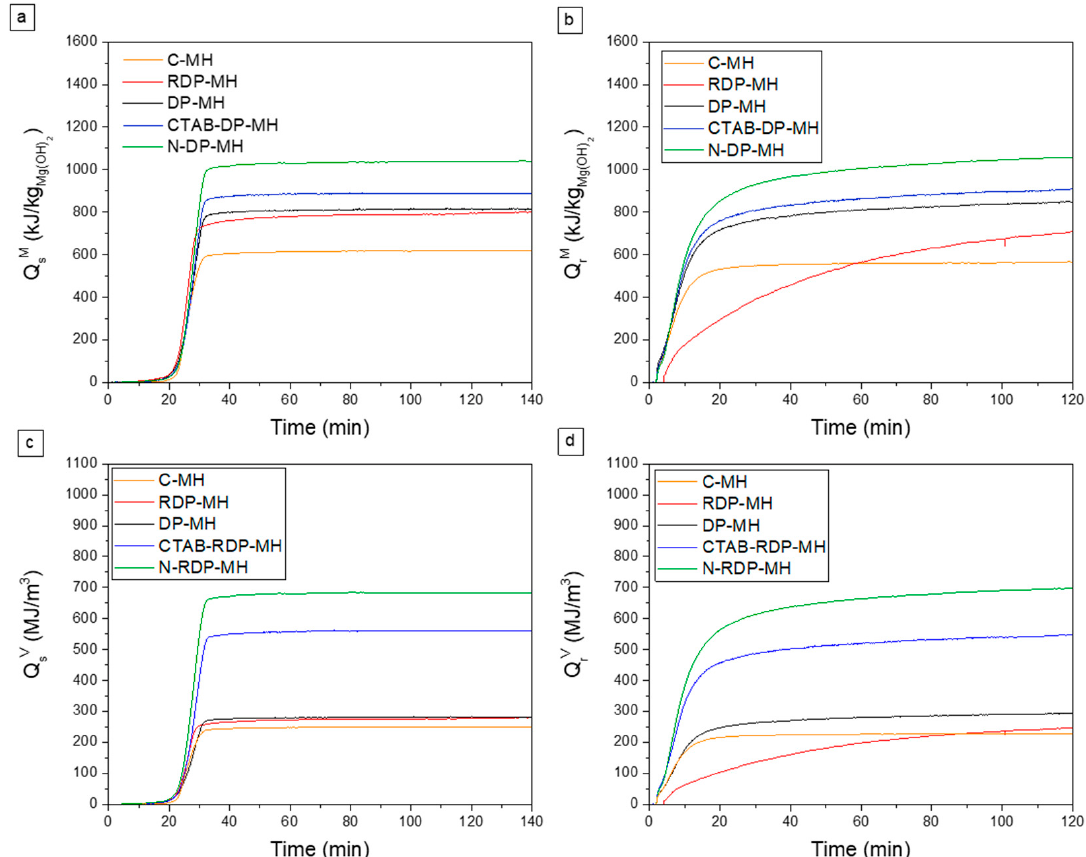
Figure 8. ( a , c ) Stored and ( b , d ) released heat per mass unit and volume unit at the 3rd cycle.